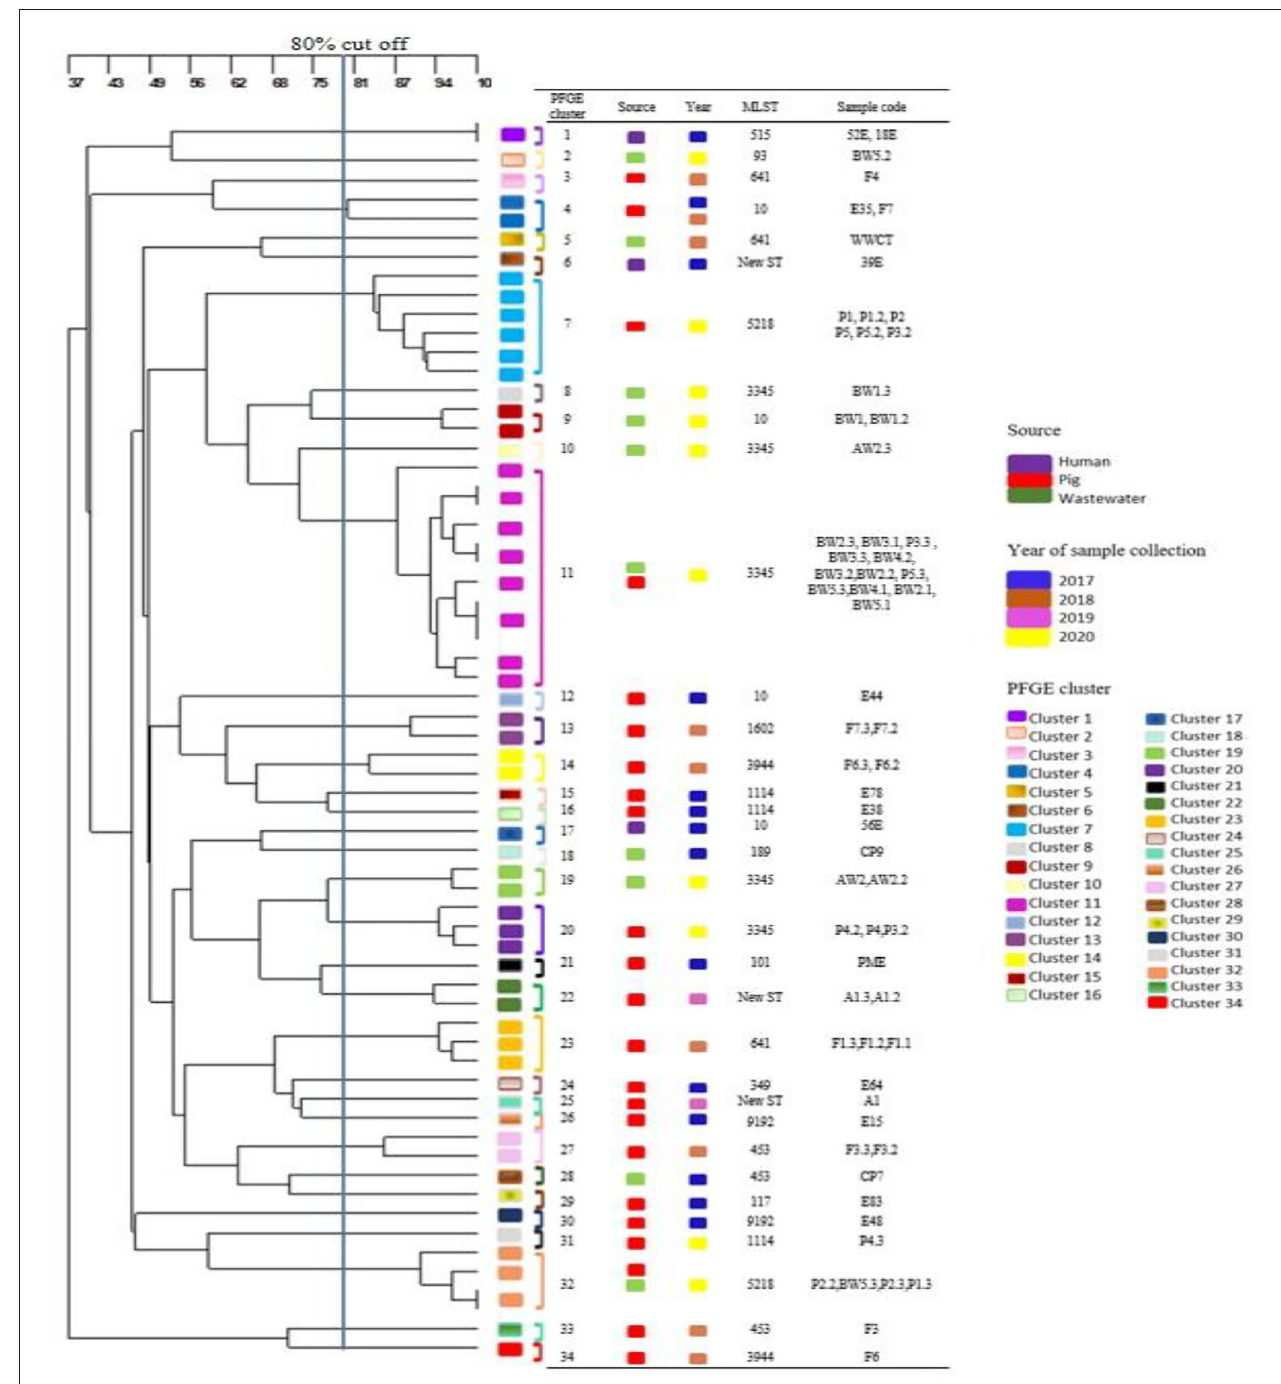
FIGURE 3 | Dendrogram generated from pulsed field gel electrophoresis analysis demonstrating the genetic relatedness among 65 mcr positive Escherichia coli strains (one to three isolates per positive sample) that were obtained from different sources at each sampling time.